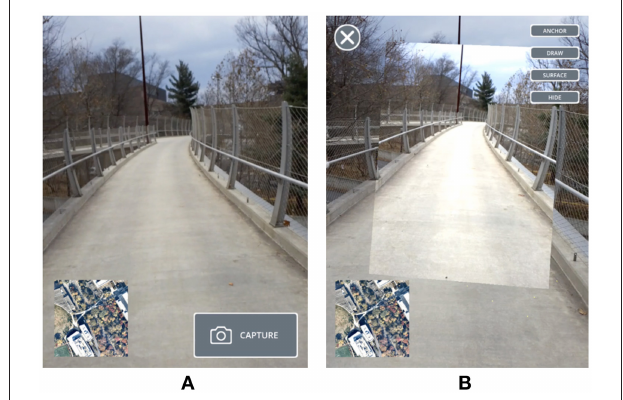
FIGURE 6 | (A) Initial interface for the prototype showing the geographic map and capture button. (B) Second interface for the prototype showing what happens after a user takes an